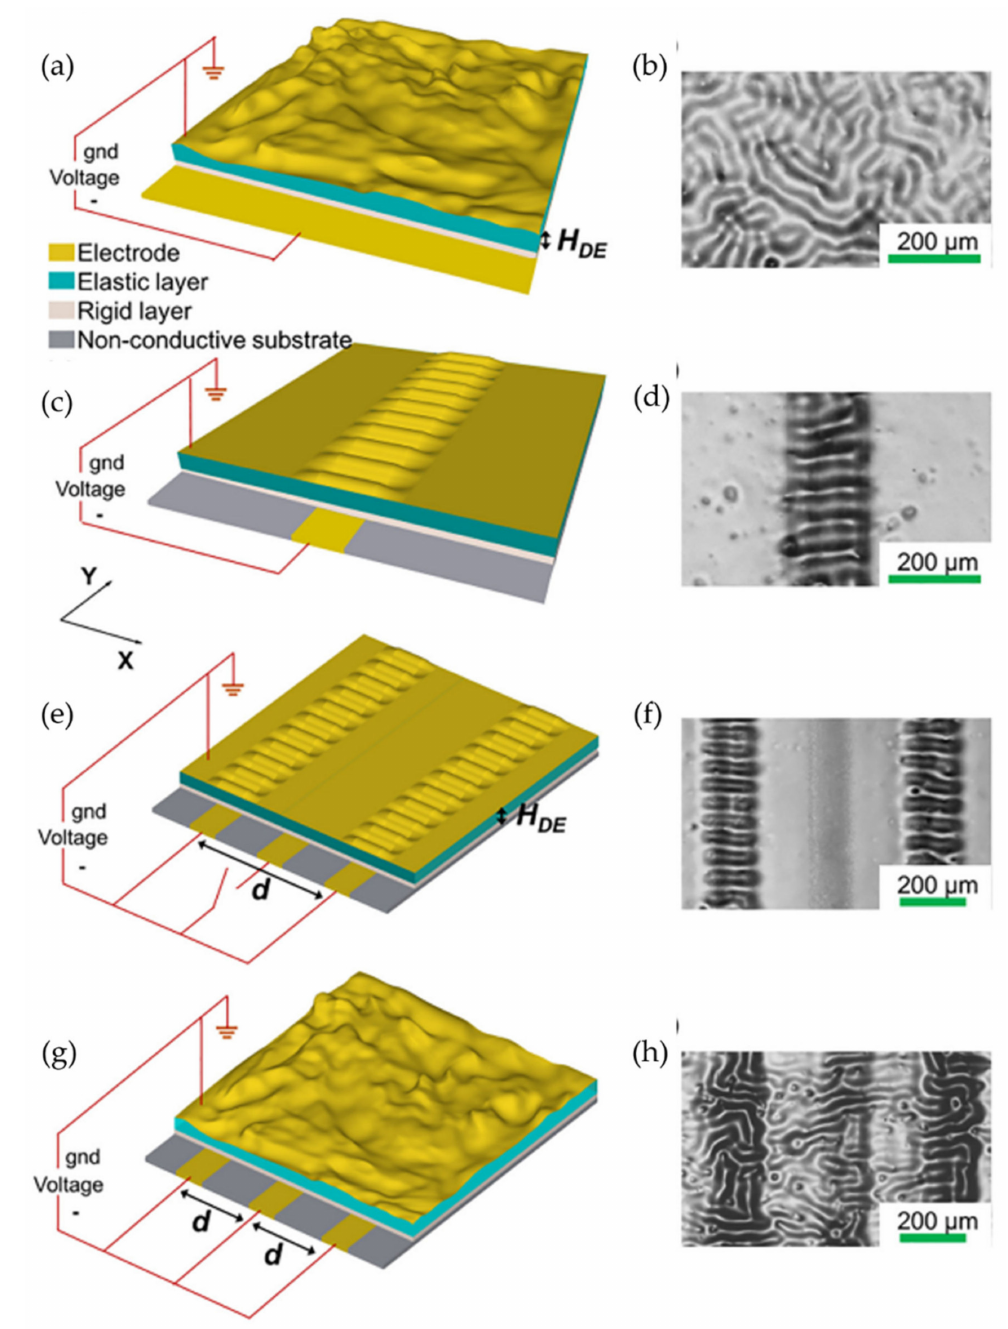
Figure 16. Schematics of the layered structure and operation with different electrode designs and the corresponding optical microscope images. ( a , b ) Randomly-oriented wrinkles, ( c , d ) When a single narrow electrode and ( e , f ) two electrodes spaced by a large distance d are used. ( g , h ) Randomly- oriented patterns when the spacing between narrow electrodes is smaller than a critical value. Reproduced with permission from reference [68]. Copyright 2020, Elsevier